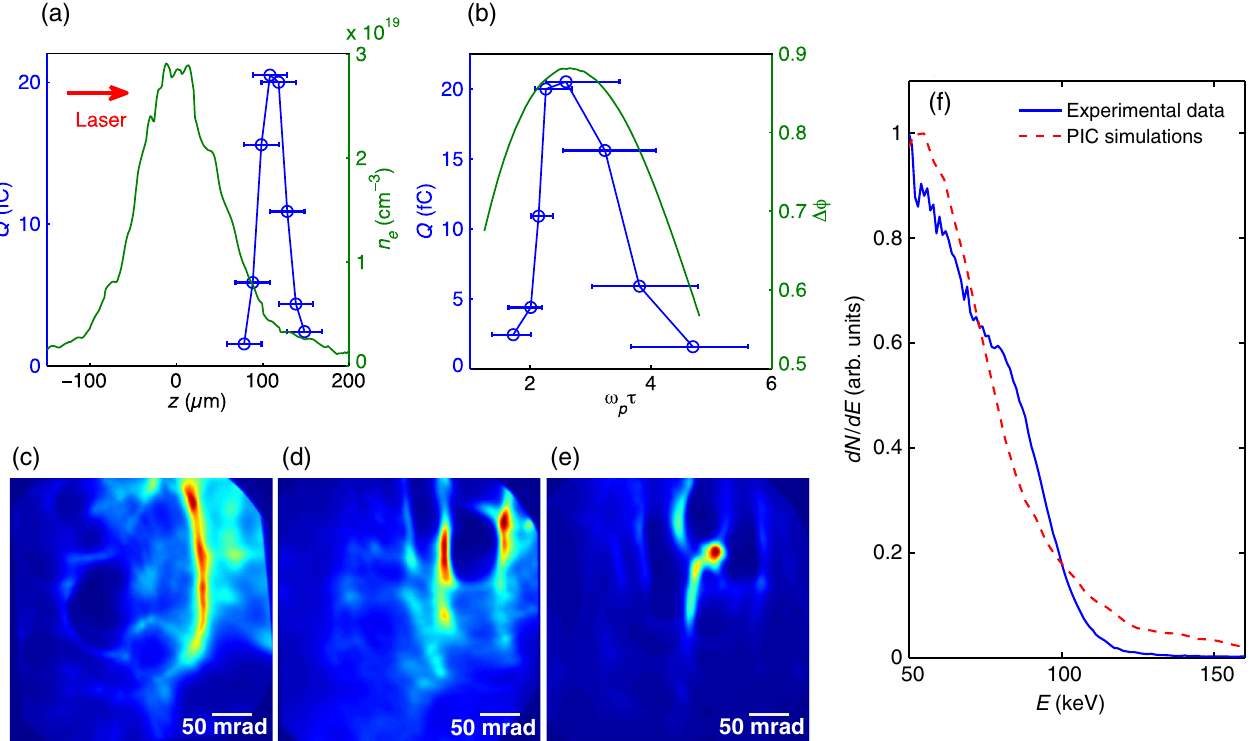
FIG. 2. Experimental results. (a) Green curve, measured longitudinal electron density profile; blue curve, charge or shot of the accelerated electrons for different positions of the laser focus. (b) Beam charge as a function of ω p ð z Þ τ , where ω p ð z Þ is estimated using the experimental plasma density at the focal plane. The green curve is the theoretical plasma wave amplitude Δ ϕ . Horizontal error bars originate from a (cid:2) 20 μ m uncertainty on the position of the focus. (c) – (e) Typical images of electron beam profiles. (f) Electron energy distribution. Blue line, experimental result; red line, distribution from the 3D PIC